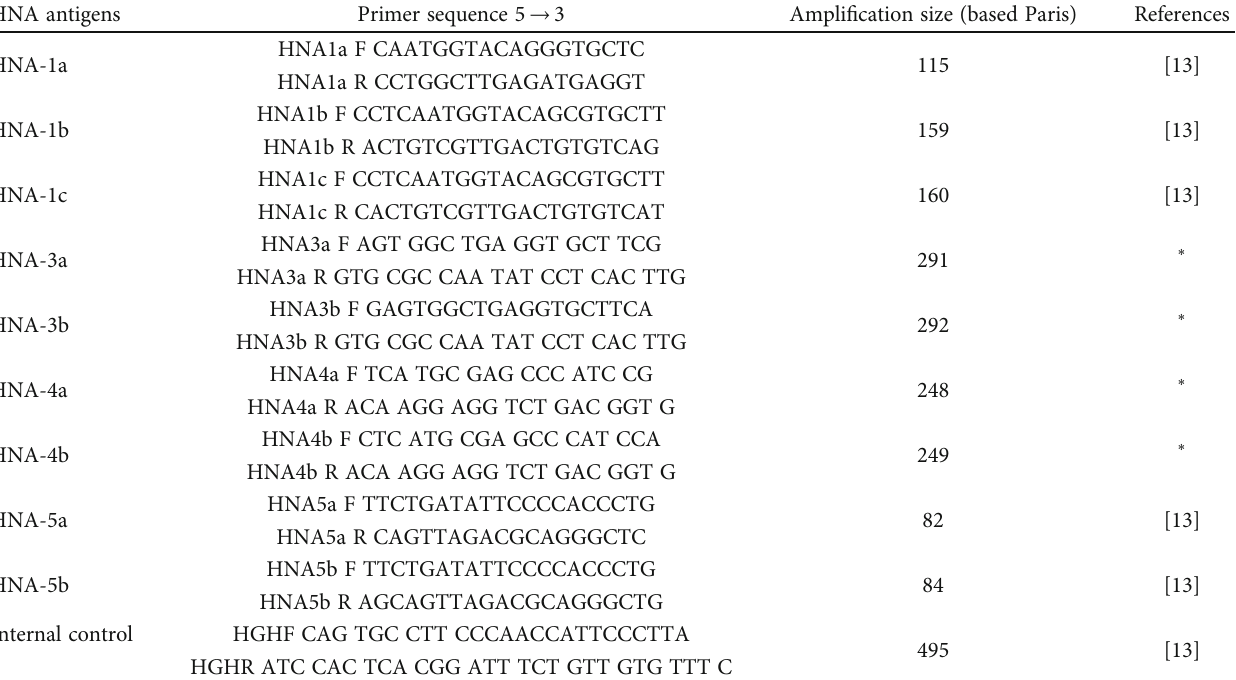
Table 2: List of primer sequences for HNA genotyping using